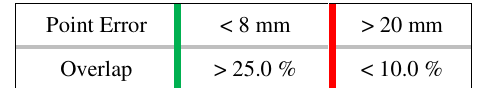
Table 2. Thresholds for point error and overlap (FARO SCENE User Manual, 2016).